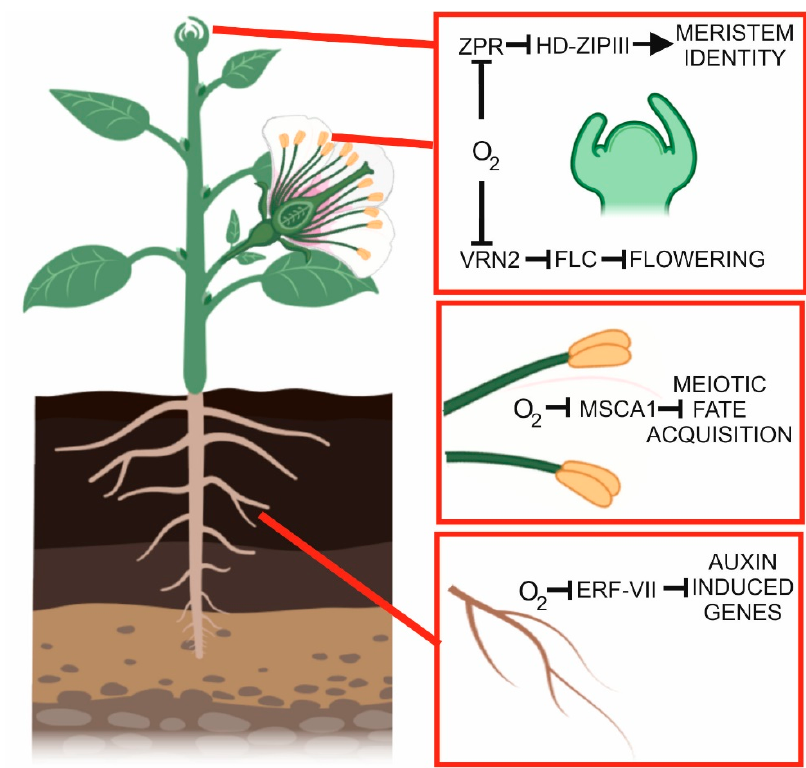
Figure 3. Hypoxic niches affecting developmental processes. In the roots, hypoxia in the lateral root primordia affects auxin-regulated genes through the action of ERF-VII proteins. In the anthers, hypoxia represents a developmental signal influencing meiotic fate acquisition (MSCA: male sterile converted anther 1). In the shoot apical meristem, a hypoxic niche controls the stability of ZPR2 and VRN2, affecting meristem identity and flowering, respectively. This figure was created using BioRender [17].